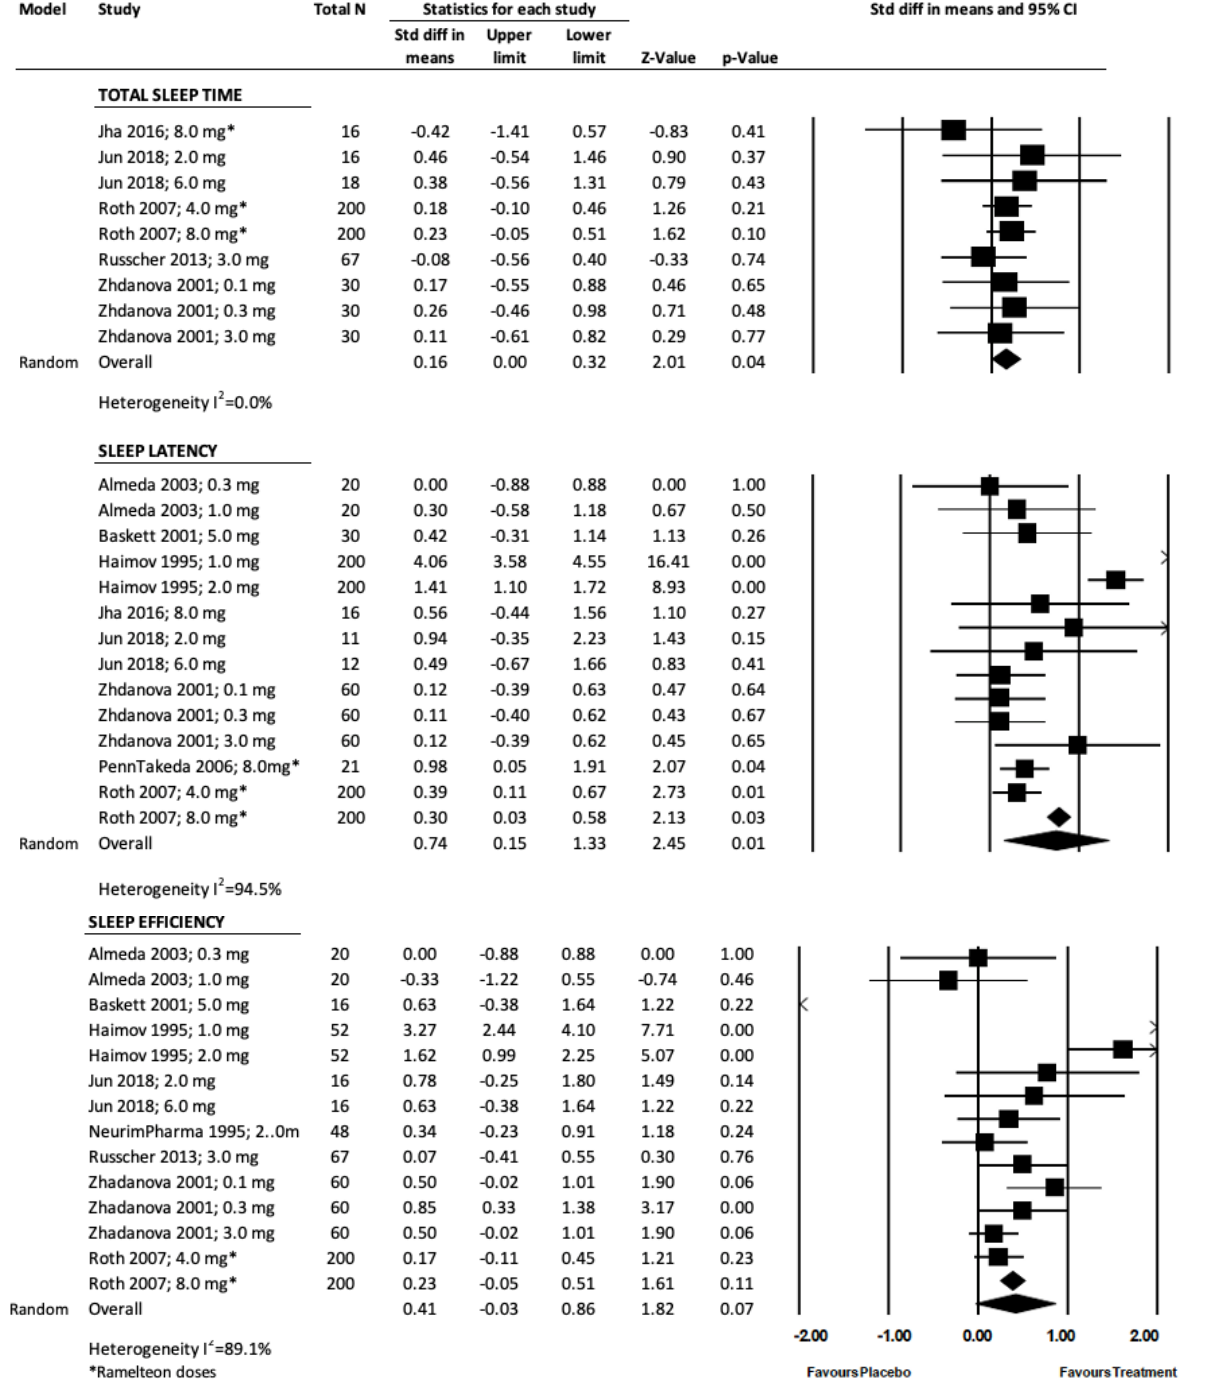
Figure 2. Objective Sleep Outcomes. The columns of the figures as labeled above in the figure represents: model, study, total N, standardized difference in means, upper limit, lower limit, Z-value, p-value, standardized difference in means and 95% CI.